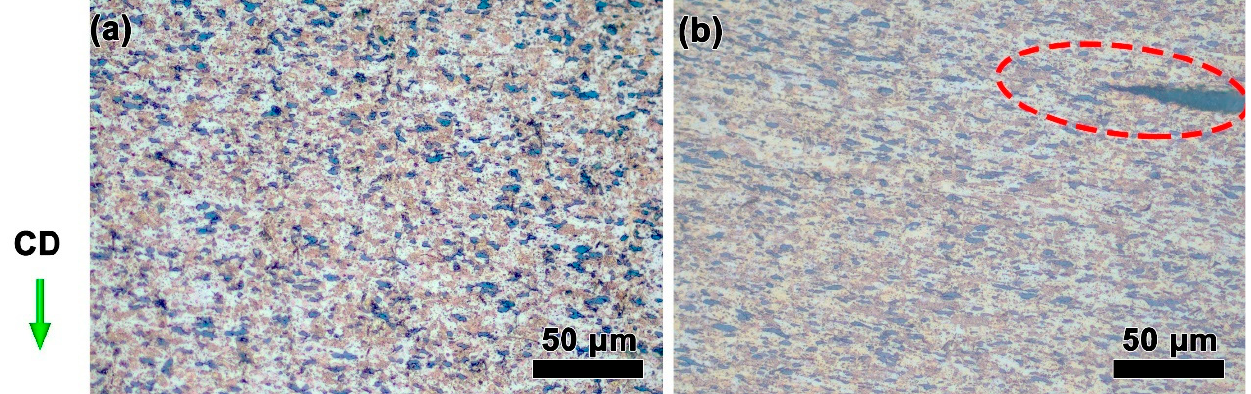
Figure 9. Microstructures of the ZnSnO 3 /Cu composites at 800 °C with different strain rates: ( a ) 0.01 s − 1 , ( b ) 1 s − 1 . CD presents the compression direction of the sample. The red dotted circle in ( b ) indicates crack.